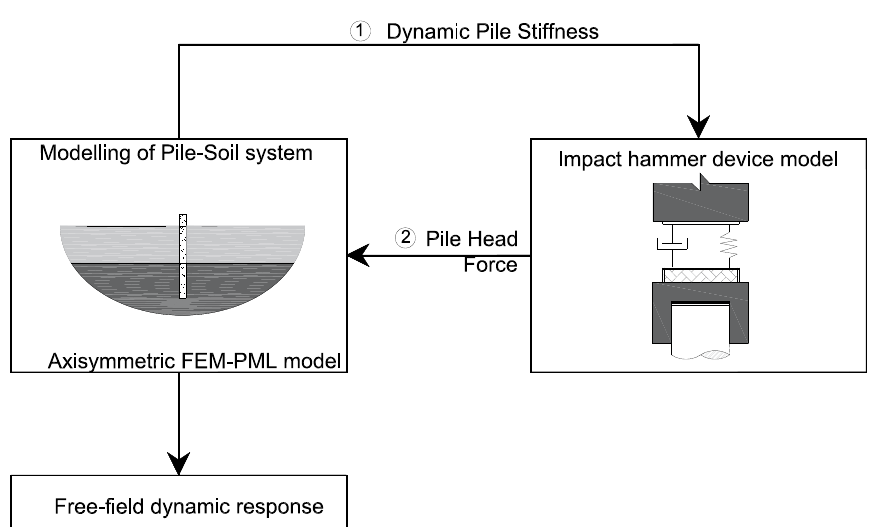
Figure 1. Representative scheme of the numerical modeling approach.